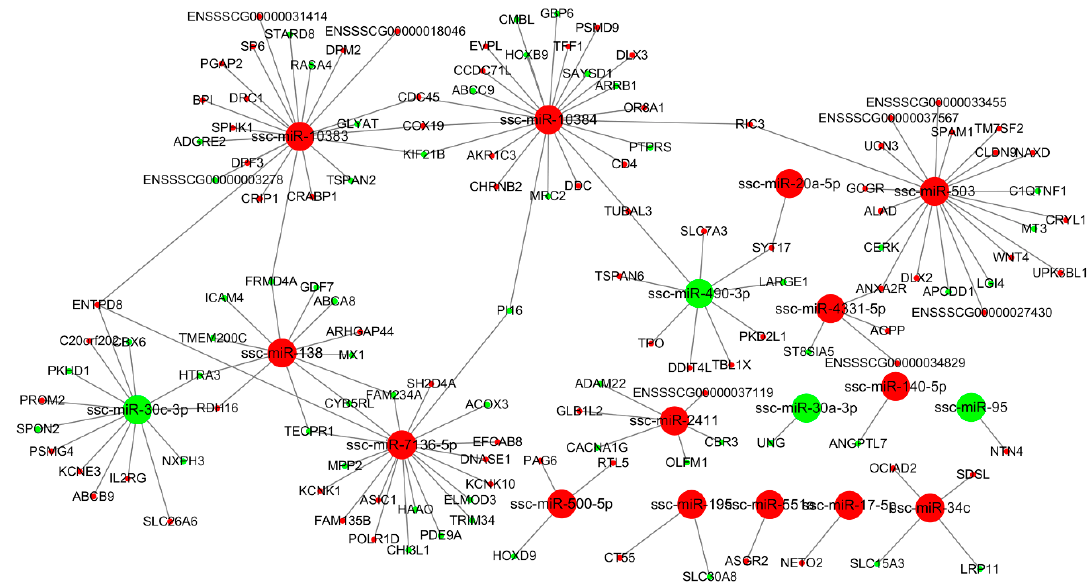
Figure 5. miRNA-gene interaction network (DU49 vs. MS49). Large and small circles represent miRNAs and genes, respectively. Red indicates that the RNA is relatively more abundant, and green indicates that the RNA is relatively less abundant in DU49 than in MS49.